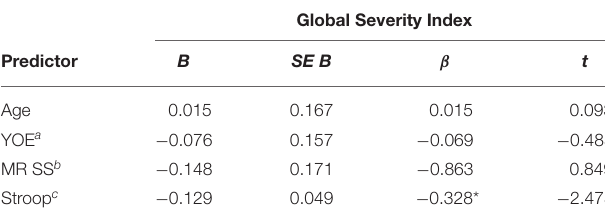
Global Severity